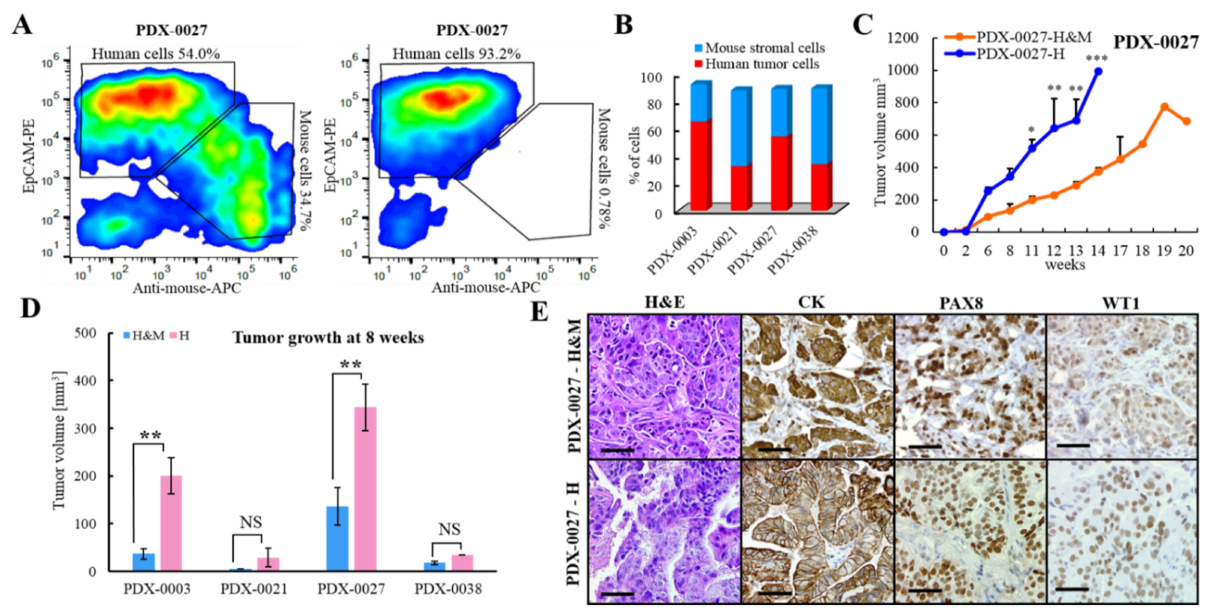
Figure 4. Assessment of the cellular composition of HGSOC PDXs. ( A ) Flow cytometry analysis of cell fractions before (left panel) and after (right panel) depletion of mouse cells from PDX-0027 by magnetic cell sorting. Cells were labeled with a pan-mouse antibody cocktail and a human-specific antibody against CD326. ( B ) Graph represents the percentage of human tumor cells and mouse stromal cells in individual PDX lines (passage 4). The cellular content was assessed by magnetic cell sorting of cells isolated from PDX, followed by flow cytometry analysis. ( C ) Graph shows tumor growth rate of PDX-0027 inoculated as pure population of human tumor cells (H) or human tumor and mouse stromal cells (H&M), (one way ANOVA followed by Tukey’s multiple comparisons test). ( D ) Graph shows tumor volumes at 8 weeks post-implantation of PDXs inoculated as H or H&M (unpaired t test). ( E ) Tumor sections were generated from PDXs developed from H or H&M. The sections were H&E stained and evaluated by IHC for HGSOC subtype markers. Scale bars: 50 µ m. ( C , D ) Data are represented as mean ± SEM. The following symbols indicate the statistical significance of data: NS = not significant, * = p < 0.05, ** = p < 0.01, and *** = p <